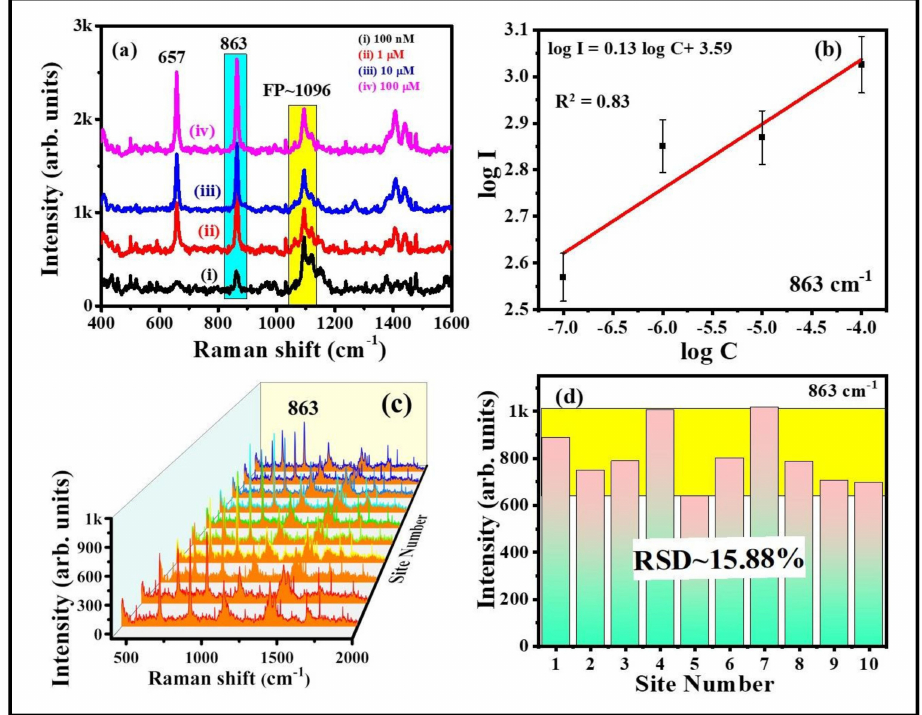
Figure 8. RDX SERS spectra recorded from optimized FP Au SERS substrate ( a ) concentration RDX SERS spectra ( b ) variation of SERS intensity versus concentration of the analyte ( c ) 3D waterfall SERS spectra ( d ) Histogram plot of RDX SERS signal intensity at 863 cm − 1 peaks collected at 10 random